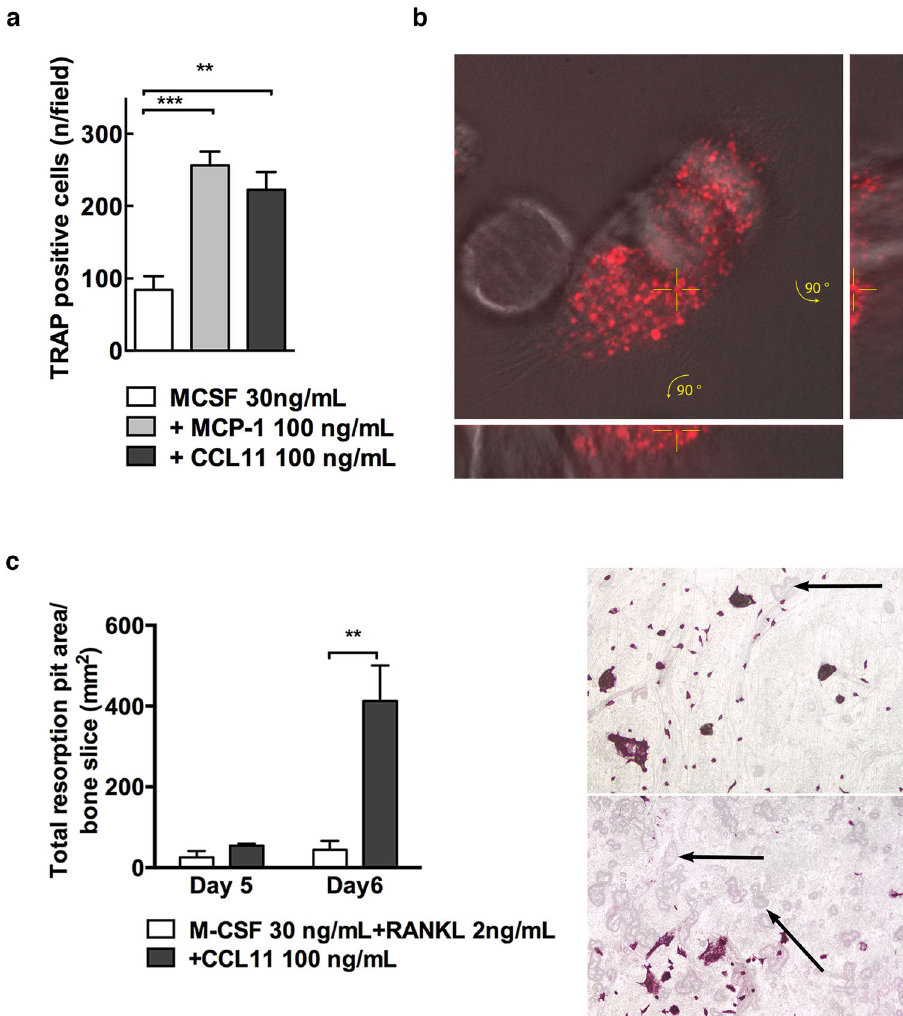
Figure 5. CCL11 binding and effects on osteoclast migration and bone resorption. ( a ) Number of TRAP + cells determined by a chemotaxis migration assay in presence of MCP-1 or CCL11. ( b ) Confocal section of living osteoclasts incubated for 30 min with Alexa Fluor ® 647 labelled rmCCL11. DIC images were overlaid with the fluorescent images to illustrate the morphology of the cells. Bottom and side projections show slice of the merged maximum projection at position indicated by yellow lines at 90° rotation. ( c ) BMM cultured on bone slices in absence or presence of rmCCL11 in medium supplemented with M-CSF (30 ng/ml) and RANKL (2 ng/ ml). Total resorption pit area measured in both groups at day 5 and 6. Data are expressed as means ± SEM. Representative images of resorption pits on bone slices and TRAP + osteoclasts in absence (upper panel) and presence (lower panel) of CCL11. Arrows point resorption